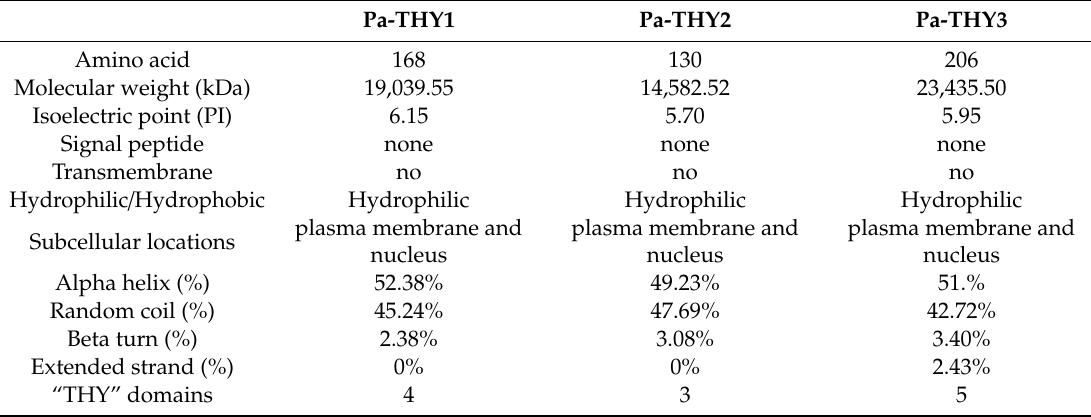
Table 1. Results of bioinformatics analysis of Pa-THYs.